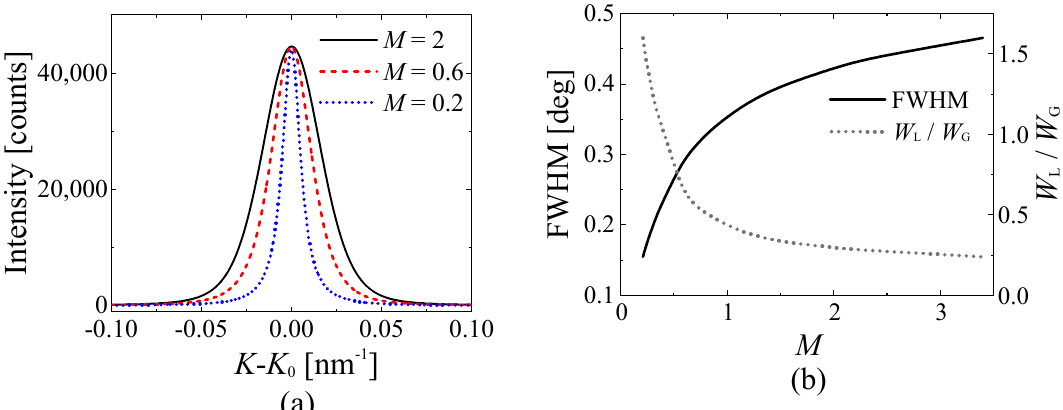
Figure 3. ( a ) Simulation of the 220 Cu reflection at a dislocation density of 2 × 10 15 m − 2 , with varying M values from 2 to 0.2; ( b ) variations in full width at half maximum (FWHM) of the 220 reflection for Cu K α 1 and W L / W G as a function of M .